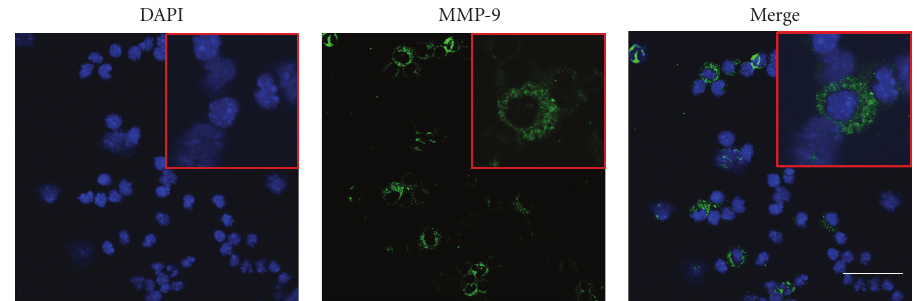
Figure 6: Localization of MMP-9 in mouse neutrophils determined by immunofluorescent confocal microscopy. DAPI, nuclear counterstained (blue); MMP-9 immunofluorescence (green). Representative neutrophils are shown at higher magnification in inset. Bar = 30 μ m.